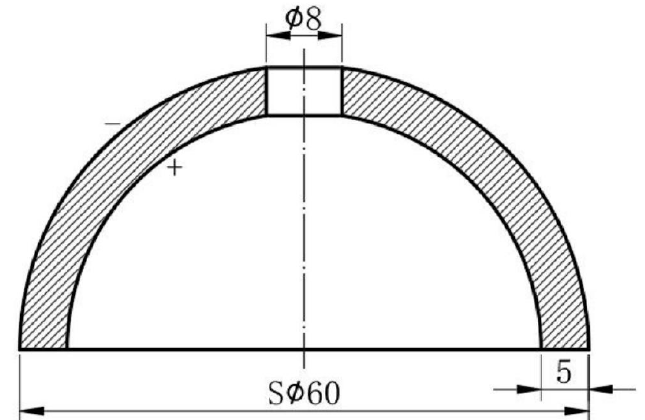
Figure 2. Dimensions of the thin-shelled hemispherical piezoelectric structure. Table 1. Electromechanical properties of the piezoceramic hemisphere.